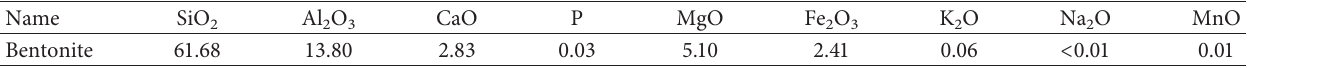
Table 1: Chemical composition of bentonite (wt%).